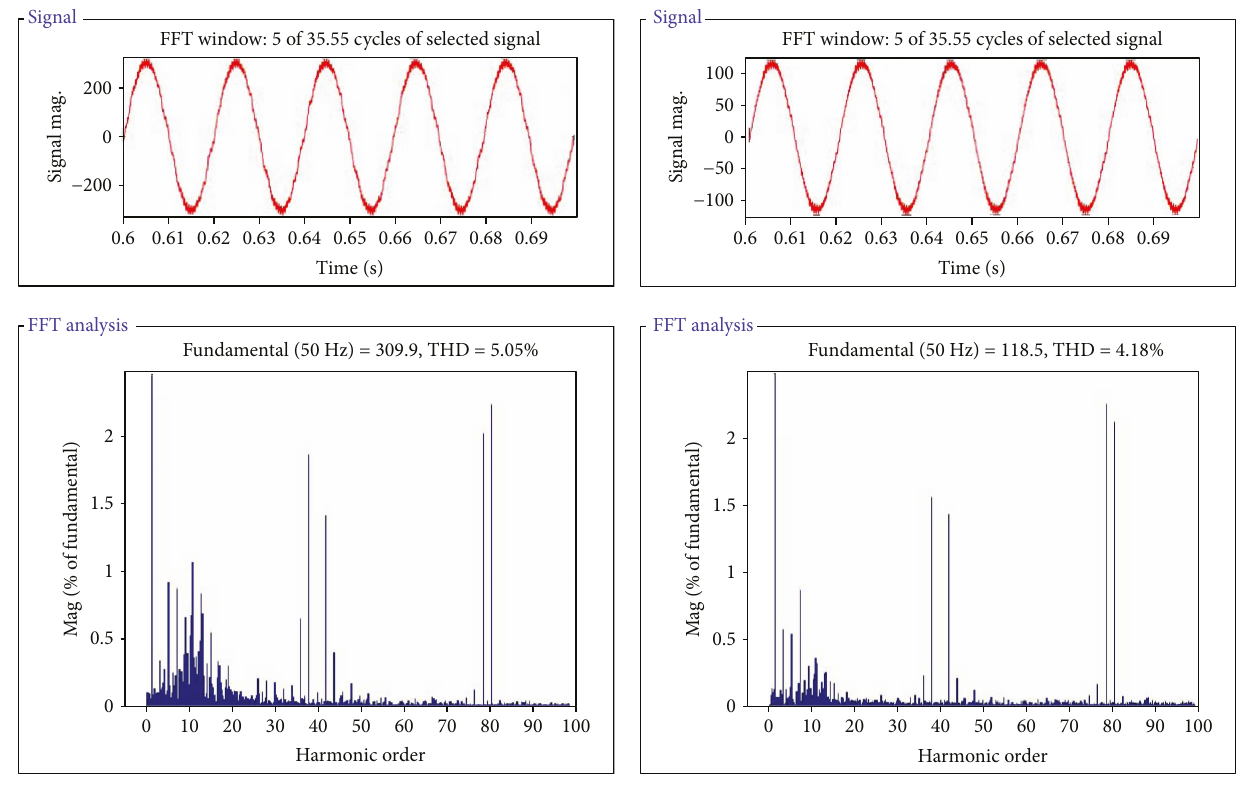
Figure 11: FFT analysis of phase to neutral voltage and line current on the electric network of the